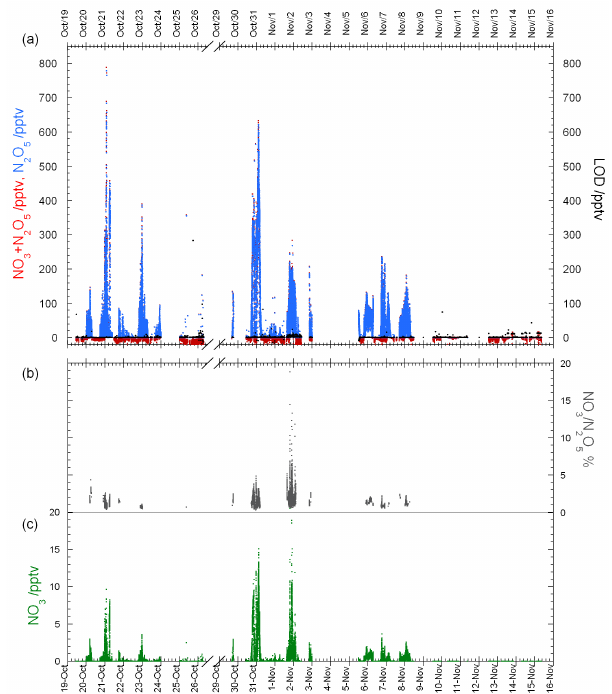
Fig. 4. LED-BBCEAS measurements of mixing ratios of NO 3 +N 2 O 5 ( a , red) from the REPARTEE-II campaign. All raw data (15s acquisitions) shown. A quantifiable measurement exists for all times where a LOD (a, black) is shown. Data partitioned into N 2 O 5 (a, blue) and NO 3 ( c , green) where required ancillary data (NO 2 and ambient temperature) is available. (b) (grey) shows NO 3 /N 2 O 5 ratio in %.